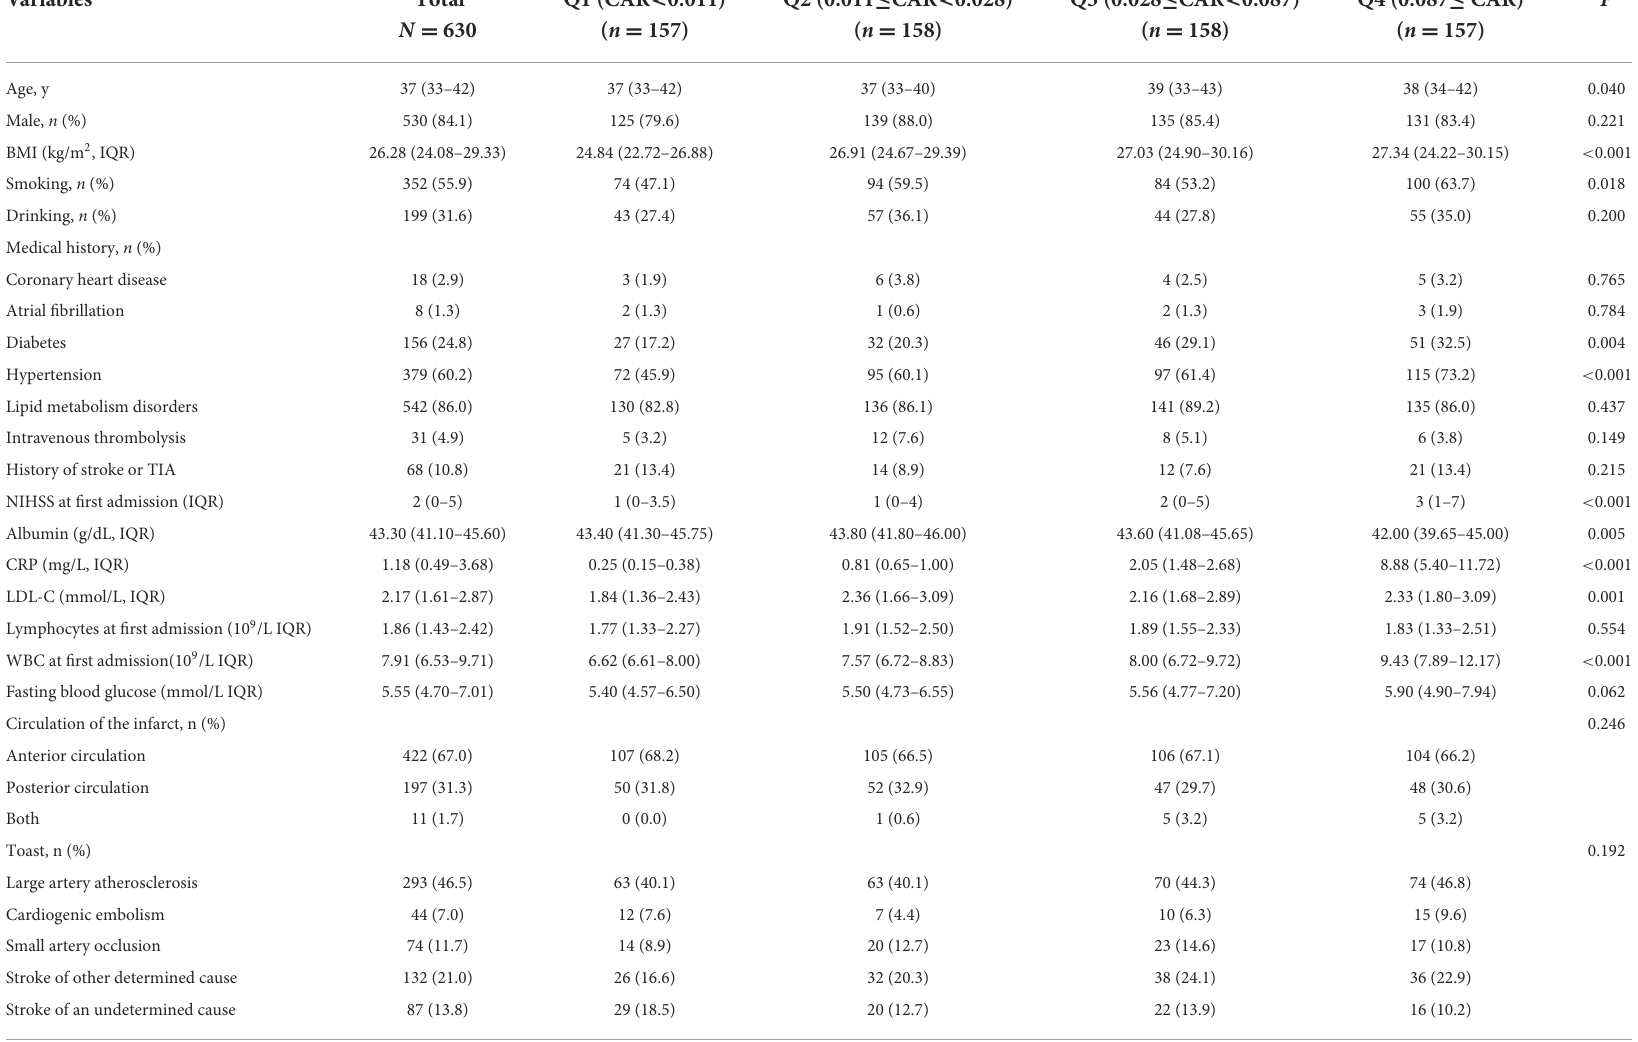
TABLE 1 Baseline characteristics of the patients stratified by the CAR.